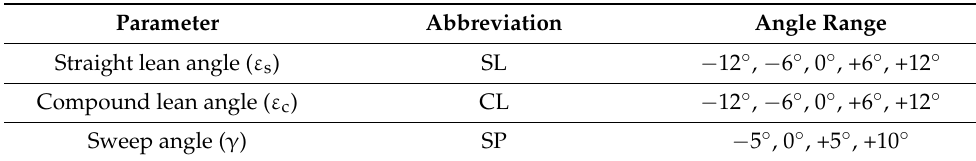
Figure 3. Definitions of lean and sweep angle: ( a ) Circumferential view—Straight lean angle and compound lean angle; ( b ) Meridional view—Sweep angle. Table 2. Lean and sweep angle range.